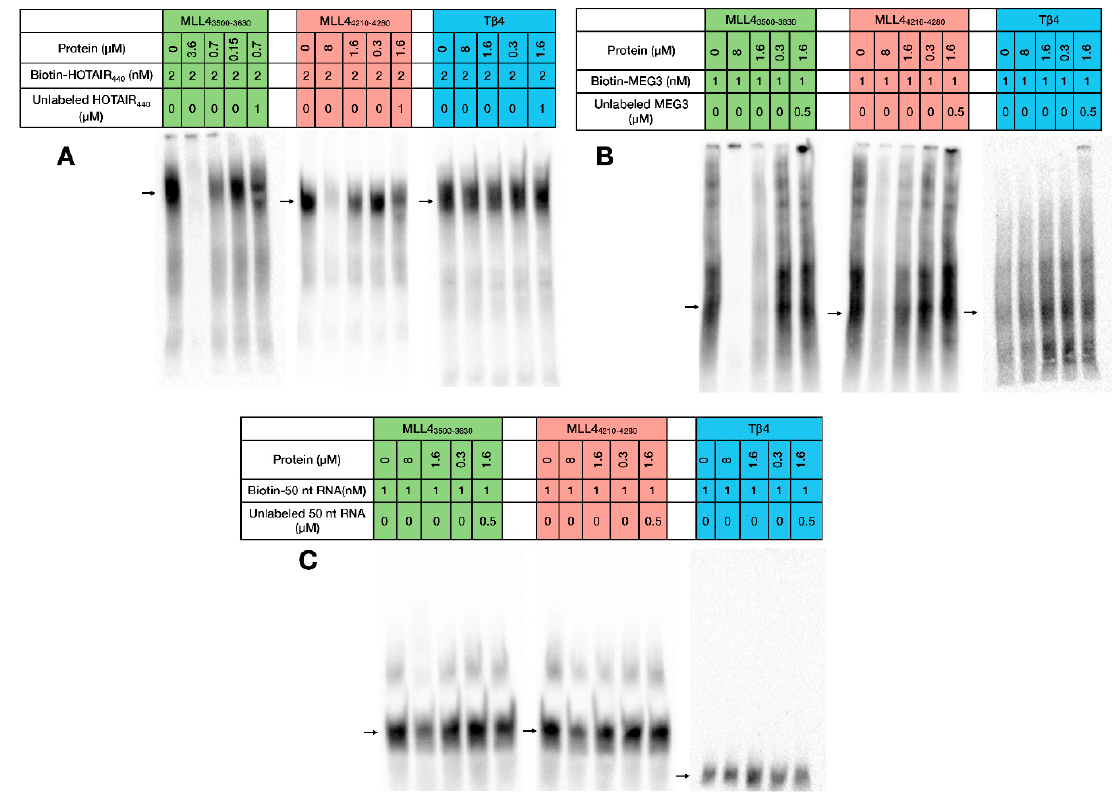
Figure 3. Electrophoretic Mobility Shift Assay. Interaction of MLL4 3500–3630 , MLL4 4210–4280 and T β 4 with HOTAIR 440 ( A ), MEG3 ( B ) and 50 nt RNA ( C ). For easier understanding, the coloring scheme of Figure 2 is followed (MLL4 3500–3630 : green MLL4 4210–4280 : red, T β 4: blue). Free RNA is indicated by arrows.